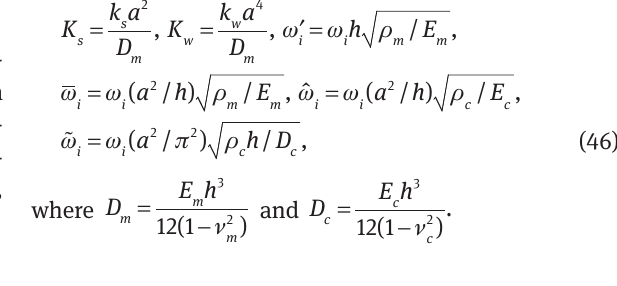
Table 4: Comparison study of the nondimensional fundamental frequency parameter